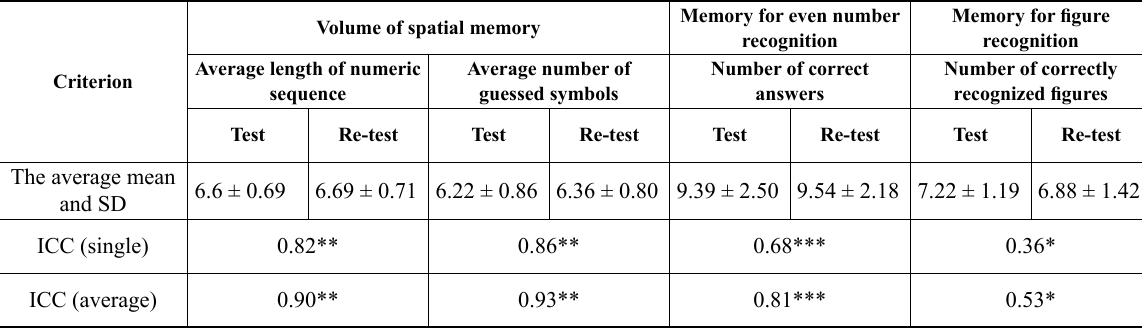
Table 1. Results of the assessment of the reliability of memory tests